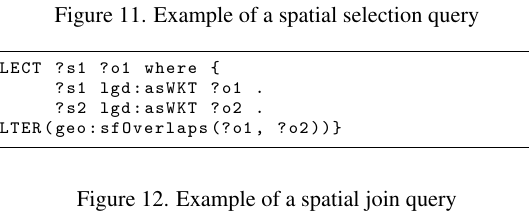
Figure 12. Example of a spatial join